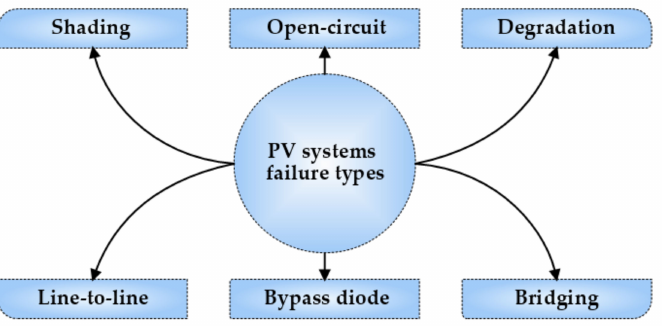
Figure 1. Common failures types in PV